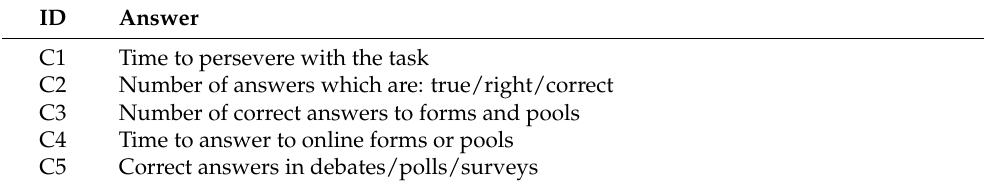
Table 3. Answers from the cognitive engagement